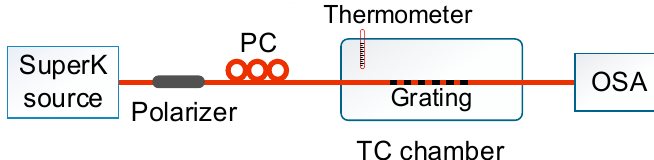
Figure 2. Experimental setup for testing spectrum properties of the hybrid grating. PC: Polarization controller; TC chamber: Temperature-control chamber; OSA: Optical spectral analyzer.